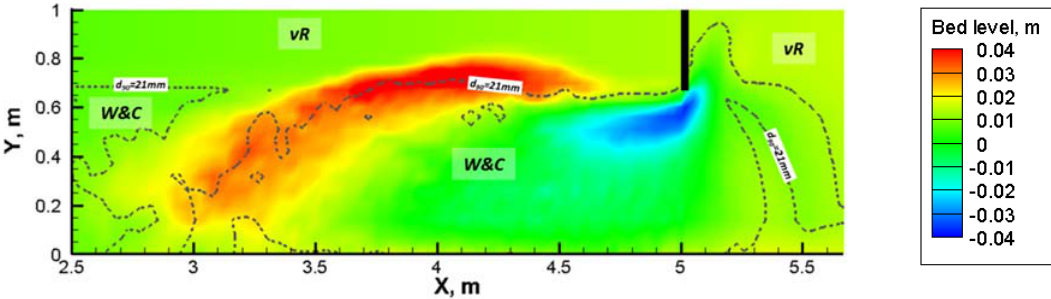
Figure 15. Equilibrium bed levels and d 90 = 0.021 m isolines (dotted lines) at Q = 58 L/s, resulting from the combined approach.